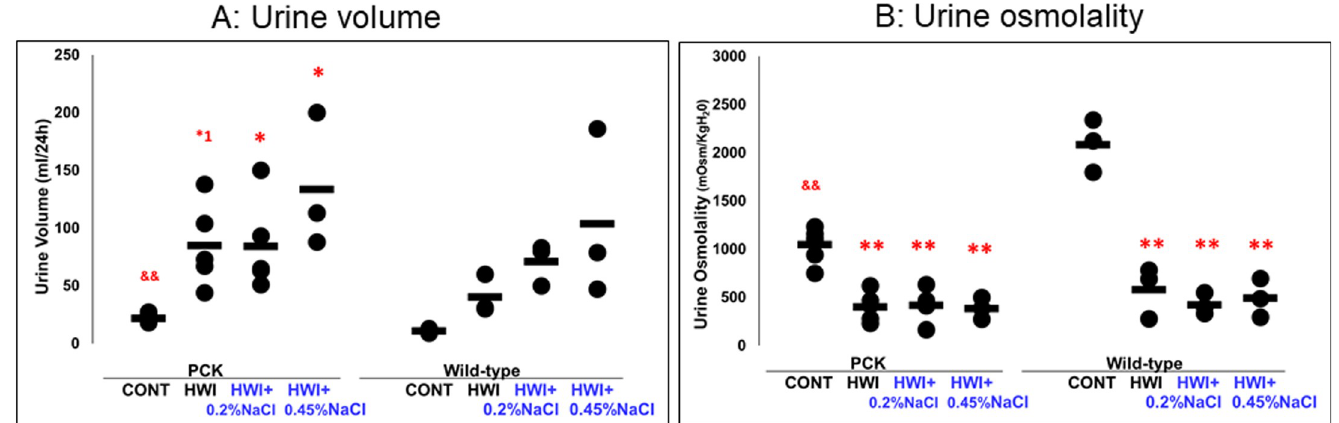
Fig 2. Effects of HWI and NaCl overload on urine volume and osmolality. CONT, distilled water group; HWI, high water intake group (5% glucose); HWI+0.2% NaCl, high water intake with 0.2% NaCl group; HWI+0.45%NaCl, high water intake with 0.45% NaCl group. Difference between PCK CONT and wild-type CONT groups: &&, P < 0.01. Comparison between CONT and treated groups: � 1, P = 0.052; � , P < 0.05; �� , P <